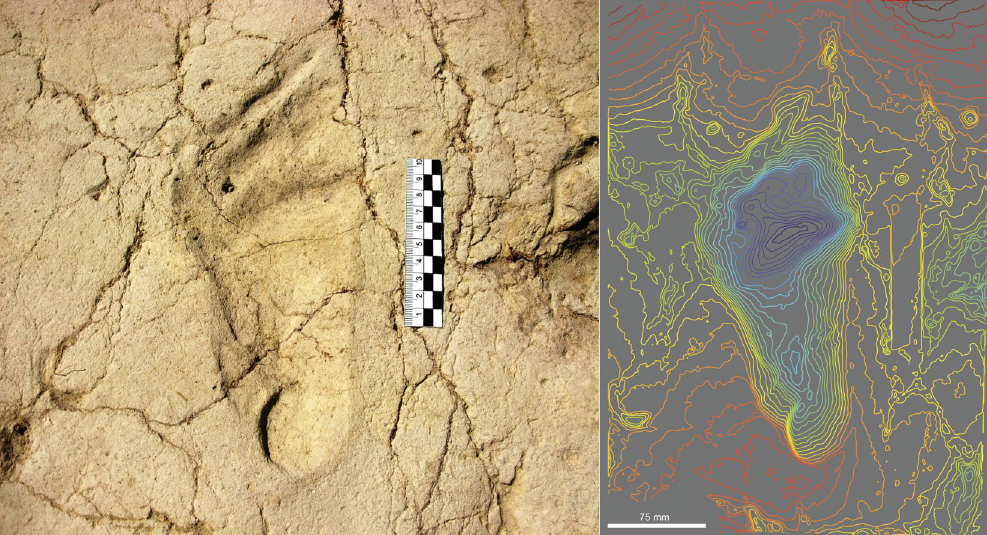
Figure 4. View and colour rendered model of the hominin track P-01, belonging to the left foot of an